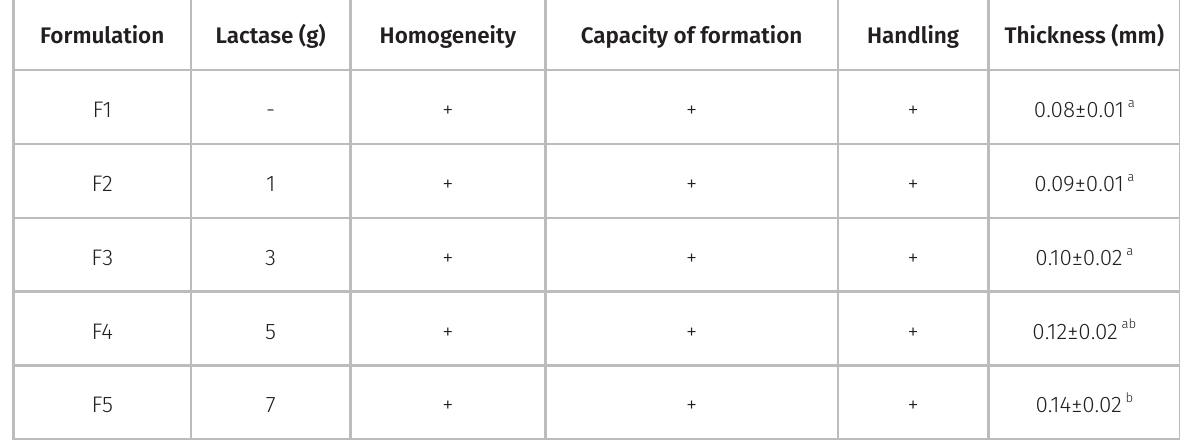
Table I. Visual aspect and thickness of HPMC-films without and with different concentrations of